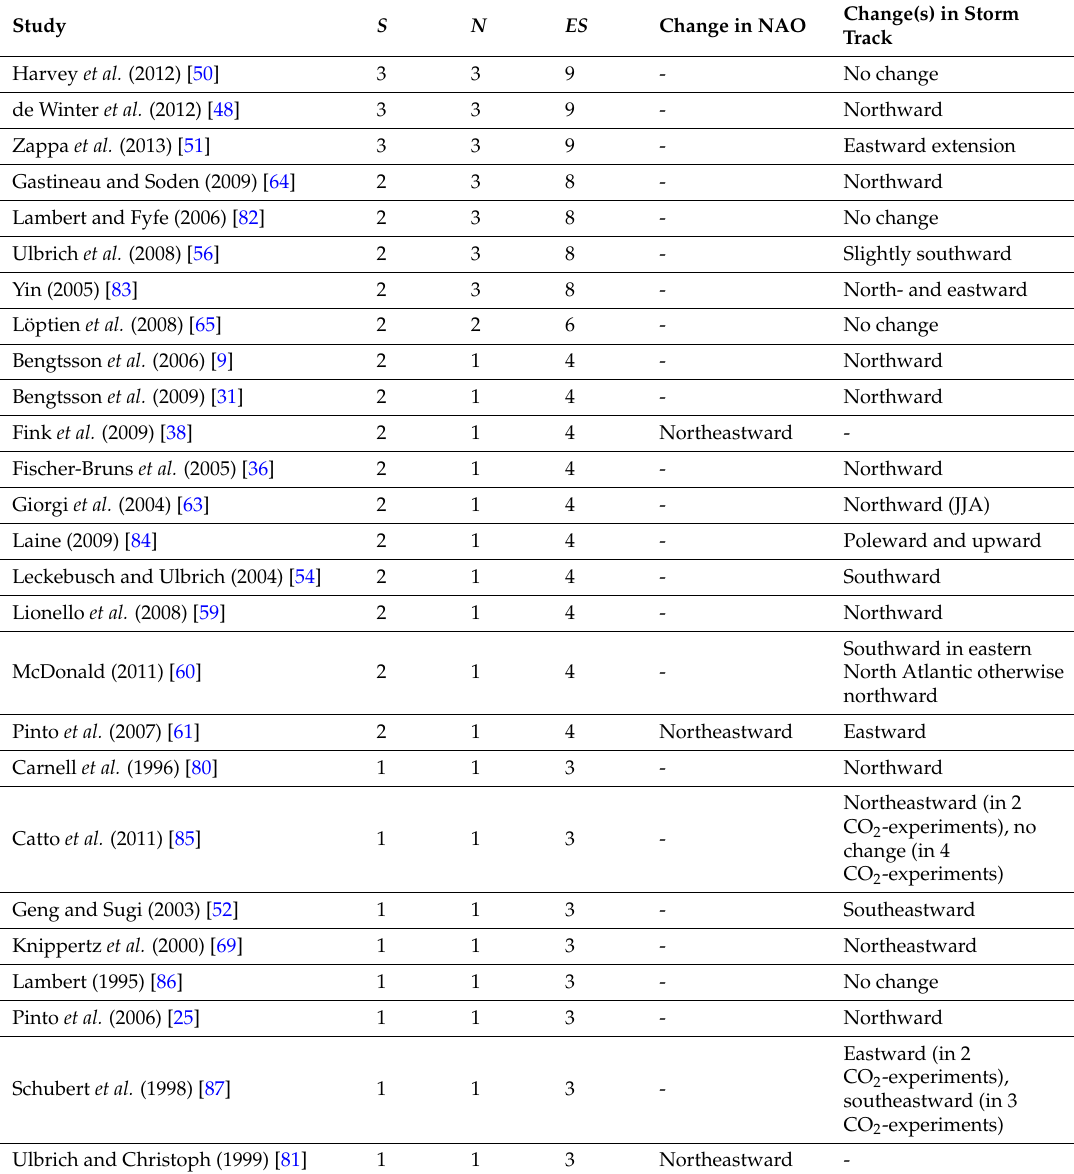
Table 8. Studies reporting on projections of future NAO- and/or storm track characteristics over the